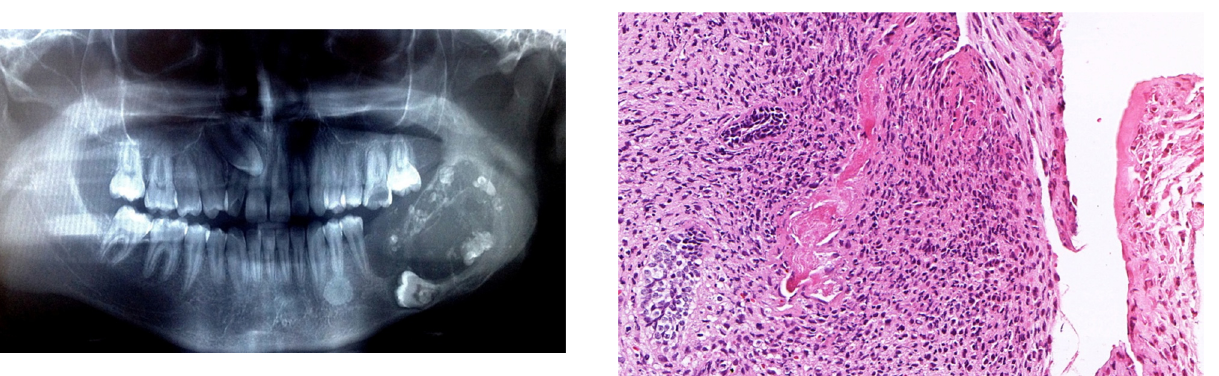
Figure 2 Panoramic radiograph showing multilocular exten- sive radiolucent lesion with radiopaque foci in the left mandible, associated with impacted molar (36).